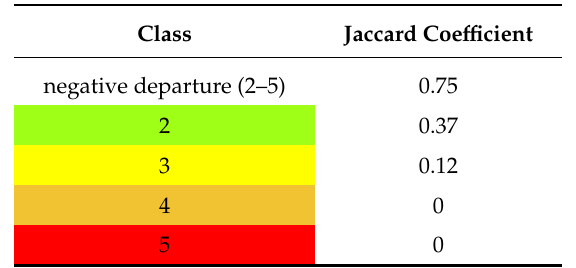
Table 3. Similarity between NDVI products from MODIS and Sentinel-2 with negative departure. Class colors correspond to classification of NDVI departure. Colors green, yellow, orange, and red correspond to negative NDVI departure